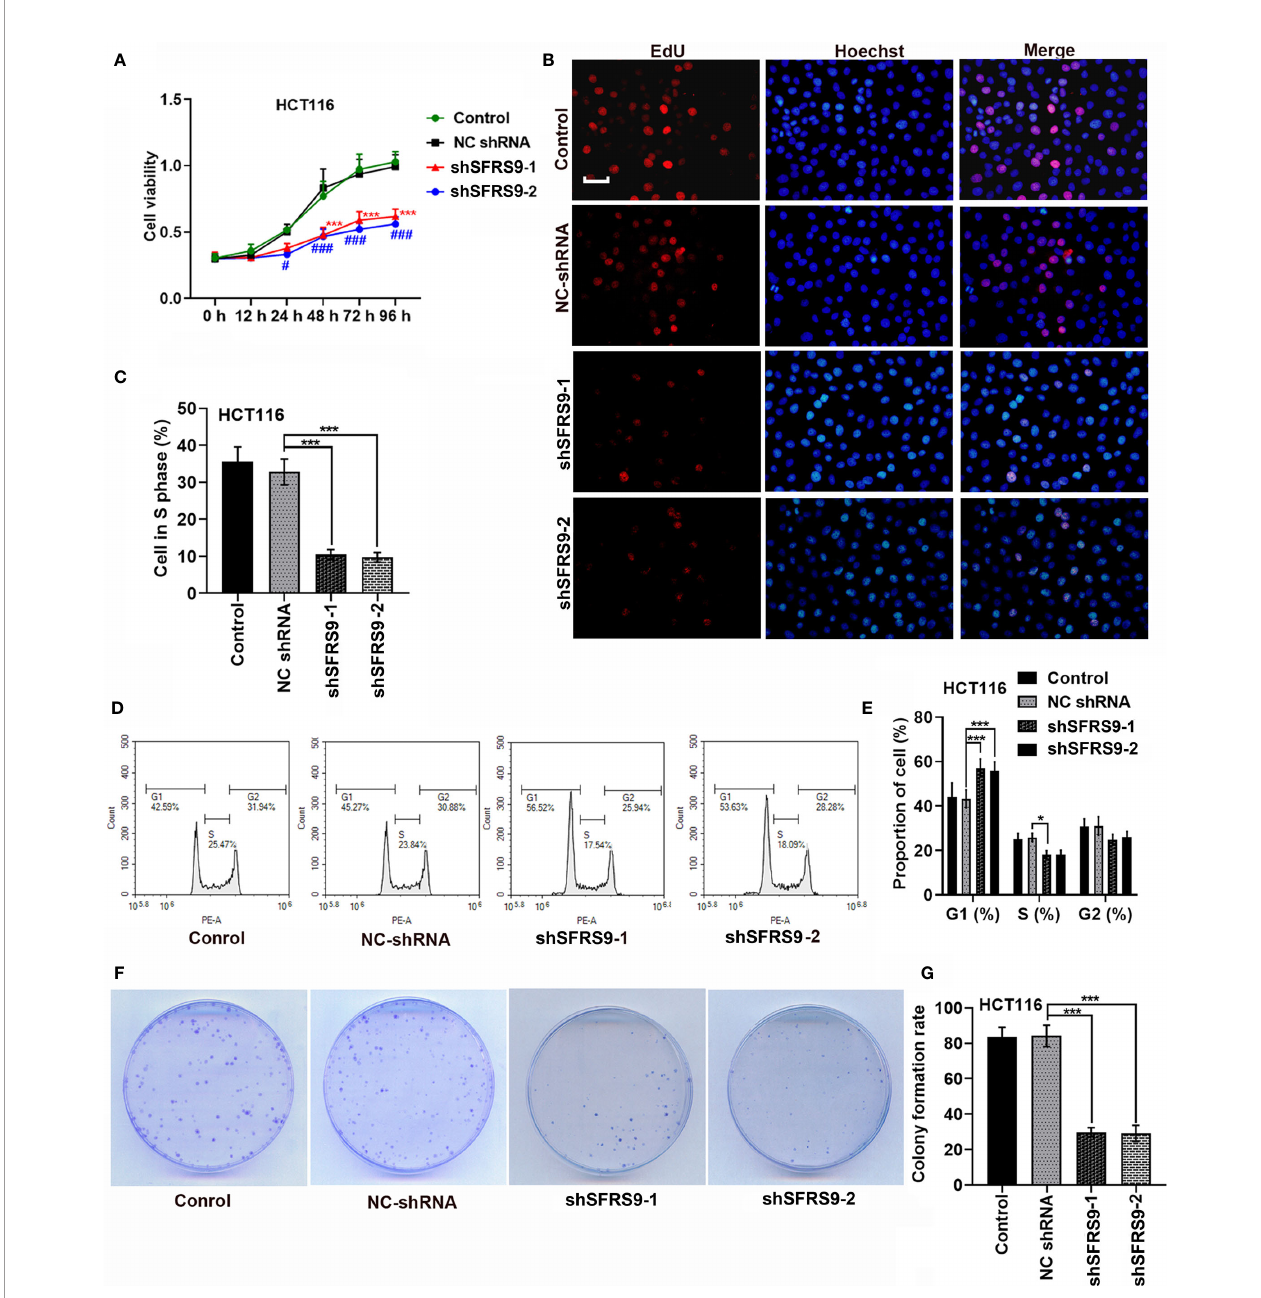
FIGURE 4 | SFRS9 knockdown inhibited the growth of CRC cells. (A) The viability of HCT116 cells was measured using the CCK-8 assay (***p < 0.001 vs. NC shRNA group; # p < 0.05, ### p < 0.001 vs. NC shRNA group). (B, C) Representative images and data analysis of EdU staining of HCT116 cells transfected with SFRS9 sh-RNAs, Scale bars: 50 m m. (D, E) Cell cycle analysis in HCT116 cells transfected with SFRS9 sh-RNAs. (F, G) Colony formation of HCT116 cells transfected with SFRS9 sh-RNAs was assessed. Values are mean ± SD. *p < 0.05, ***p <